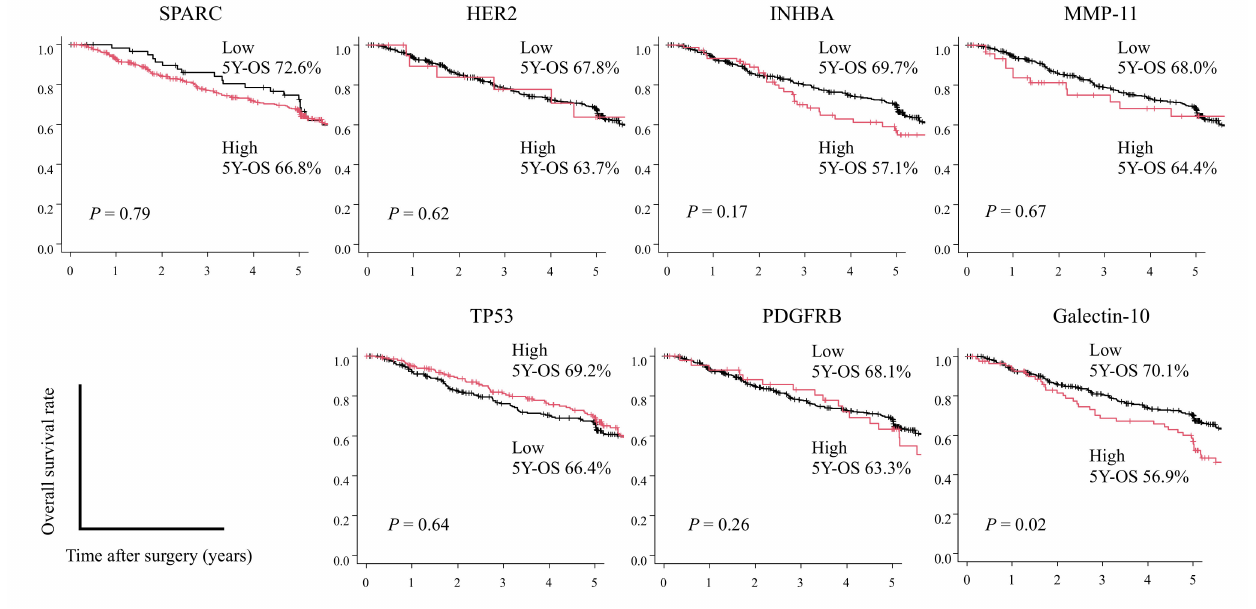
Figure 3. Overall survival rate (OS) of stage II/III gastric cancer (GC) patients according to the expression of each candidate survival risk stratification